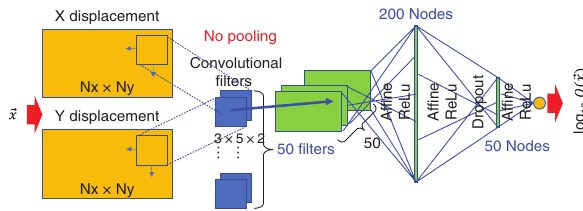
Figure 3: Configuration of the neural network prepared to learn the relationship between displacements of air holes and Q factors (ReLU: rectified linear unit. Affine: affine transformation. Dropout: random dropping of units including